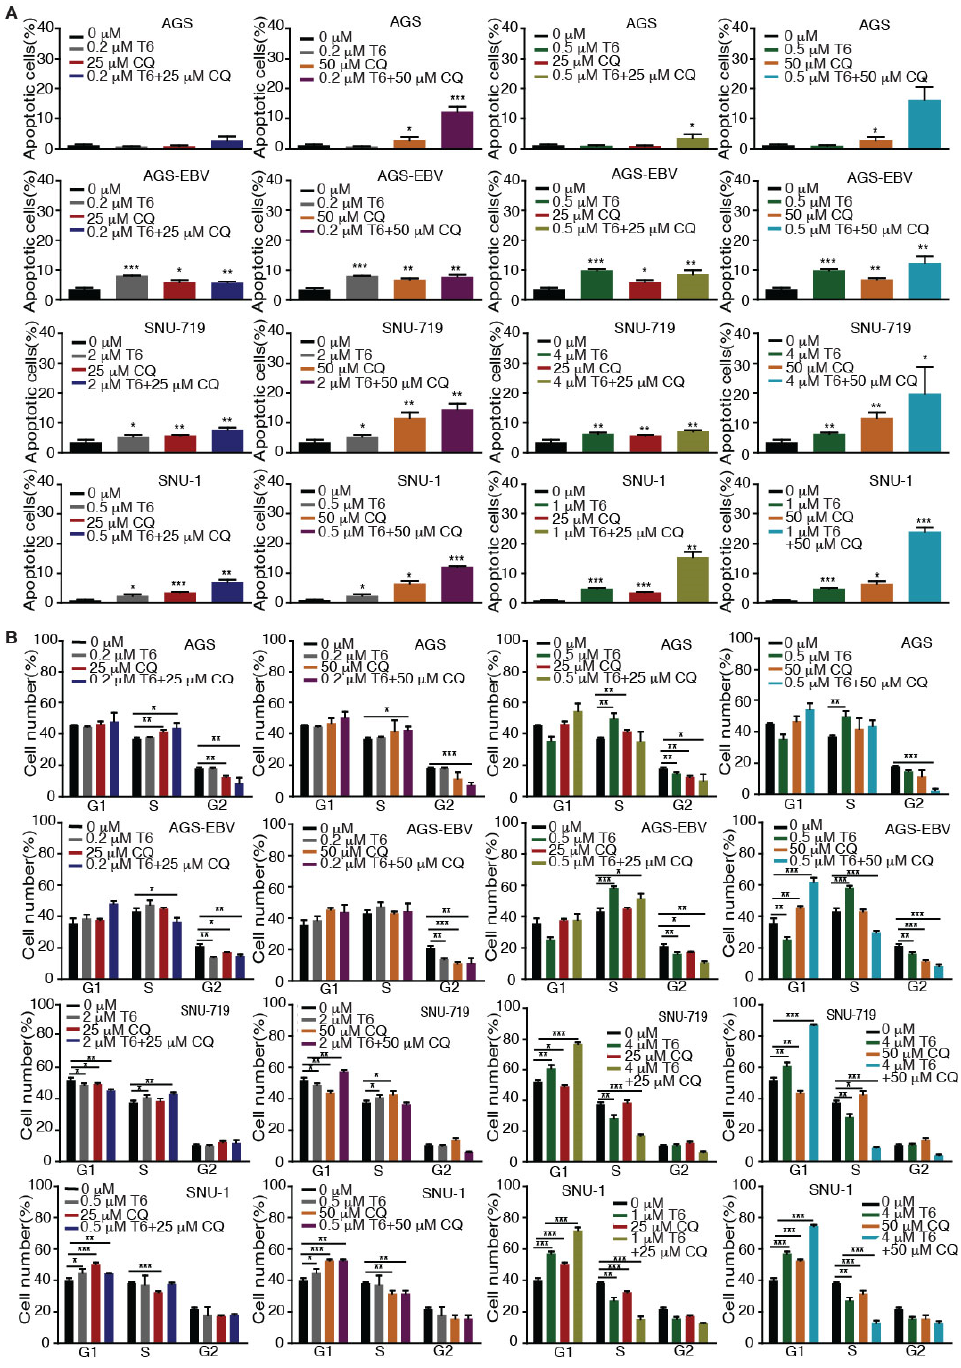
Figure 5. Tenovin-6 (T6) and chloroquine (CQ) synergistically induce apoptosis and cell-cycle arrest in GC cells. ( A ) Examination of apoptotic cells by annexin V and propidium iodide (PI) staining in AGS, AGS-EBV, SNU-719, and SNU-1 cells following treatment with different concentrations of T6 or CQ alone or in combination. * p < 0.05, ** p < 0.01, *** p < 0.001. ( B ) Examination of cell-cycle phases in AGS, AGS-EBV, SNU-719, and SNU-1 cells following treatment with different concentrations of T6 or CQ alone or in combination. * p < 0.05, ** p < 0.01, *** p < 0.001.